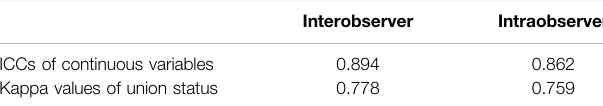
TABLE 3 | Validation of measured values repeatability. TABLE 4 | Logistic regression analysis of the cranial screw